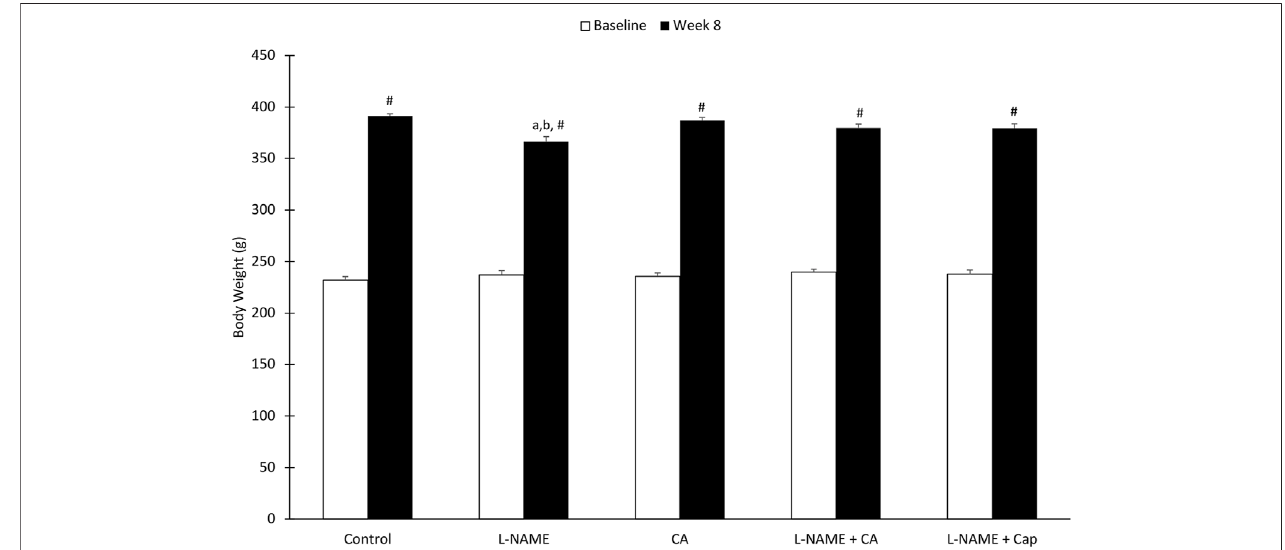
FIGURE 1 | Rat body weight before and after administration of L -NAME (40 mg/kg orally) and C. asiatica extract (500 mg/kg orally) or captopril (5 mg/kg orally) during the 8-weeks of study. The values represent mean ± SEM ( n (cid:1) 6). # versus baseline ( p < 0.05), a versus control ( p < 0.05), b versus C. asiatica ( p < 0.05).